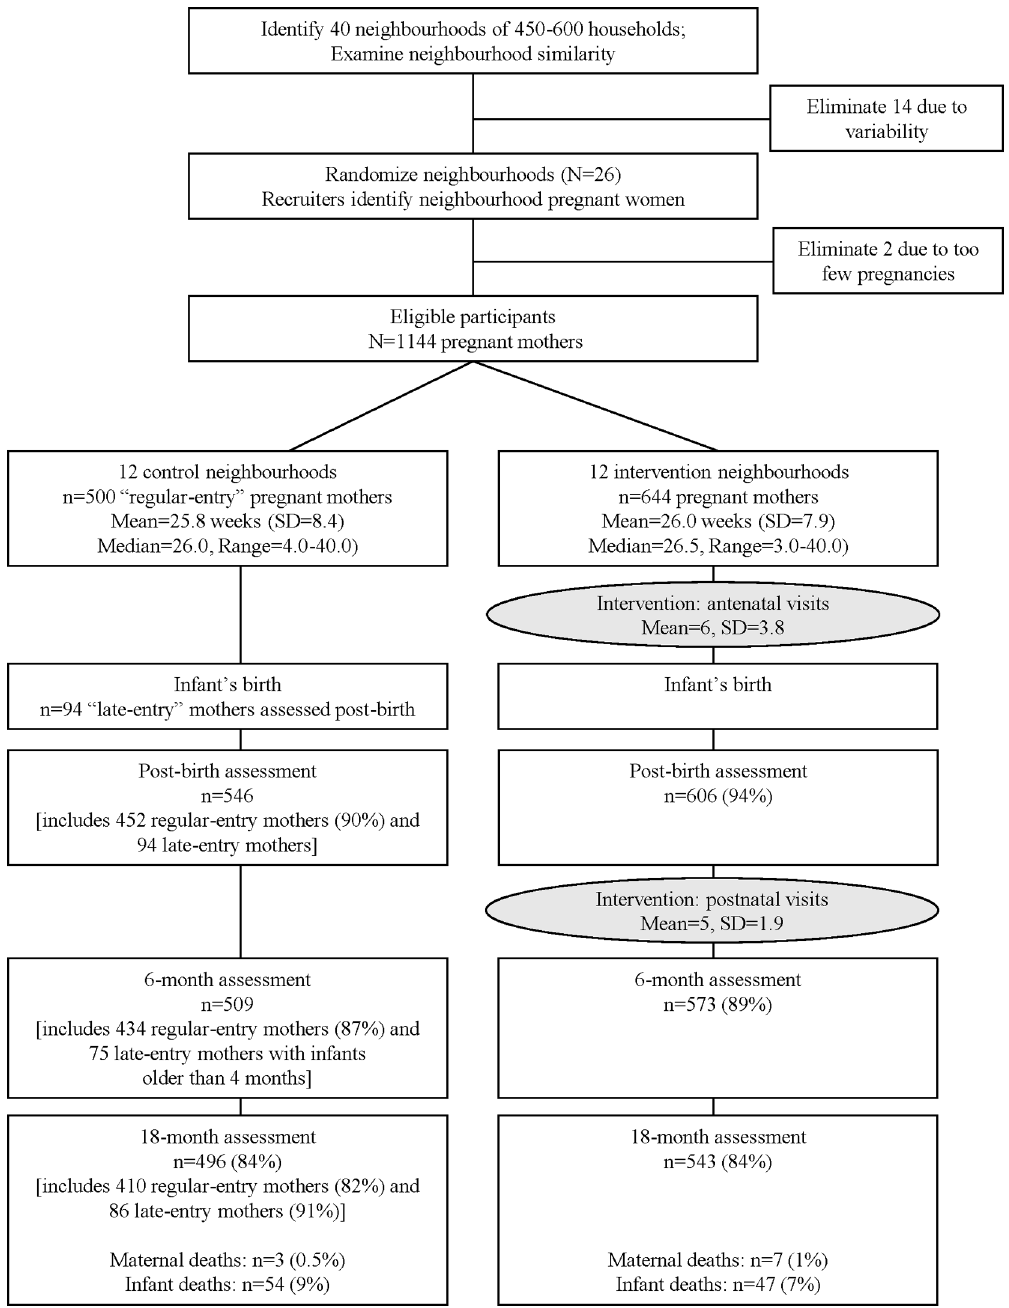
Figure 1. Movement of participants through the trial at each assessment point for mothers in the control and the intervention